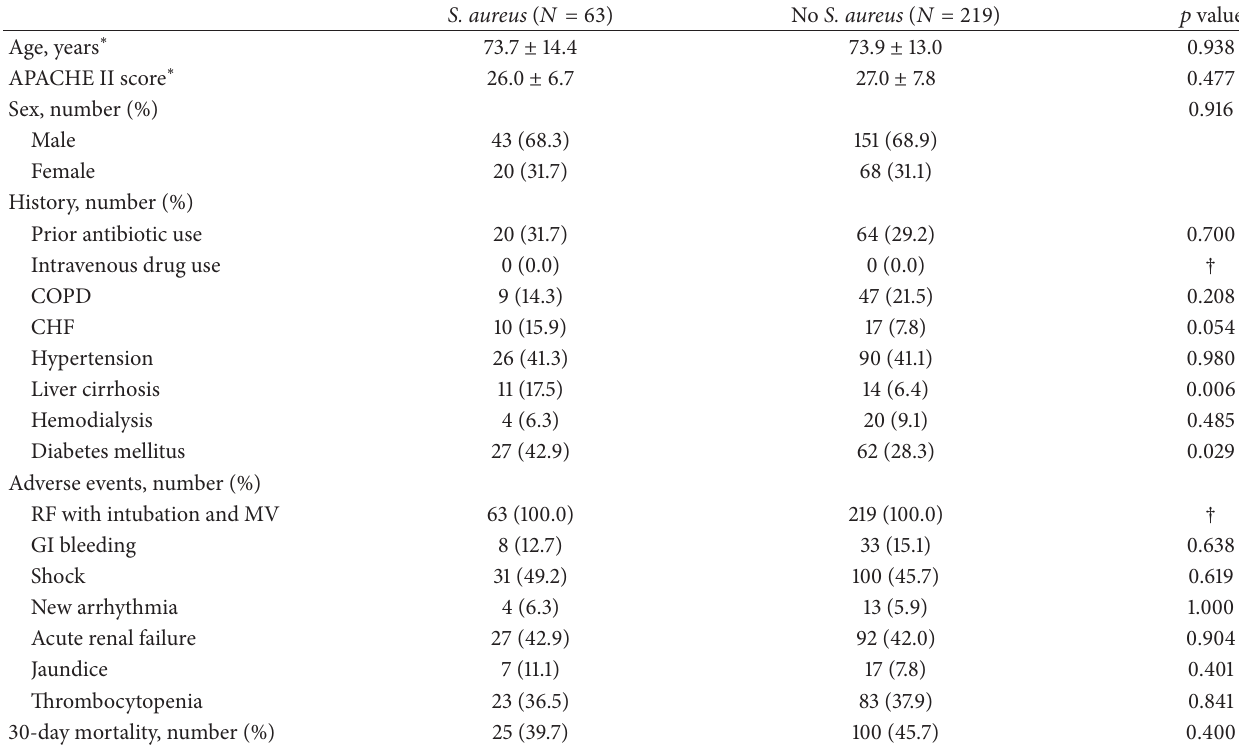
Table 1: Clinical characteristics between presence and absence of S. aureus infection in HCAP or HAP patients with severe sepsis. S. aureus ( 𝑁 = 63 )